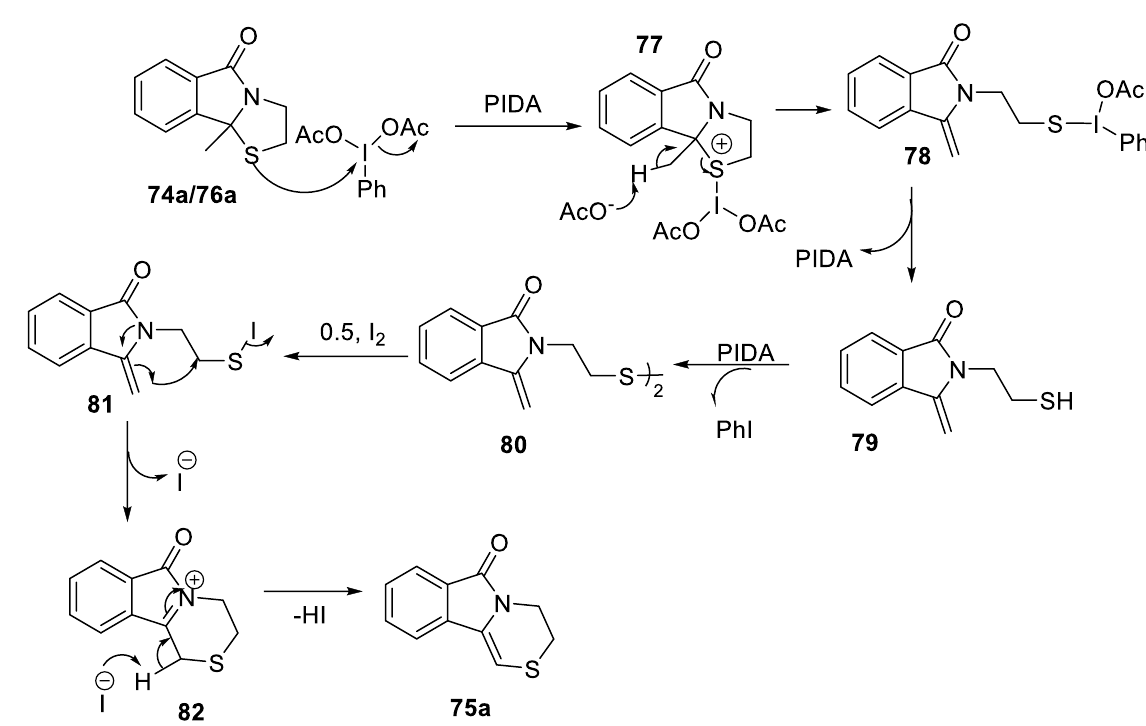
Figure 12. Proposed mechanism for ring expansion.